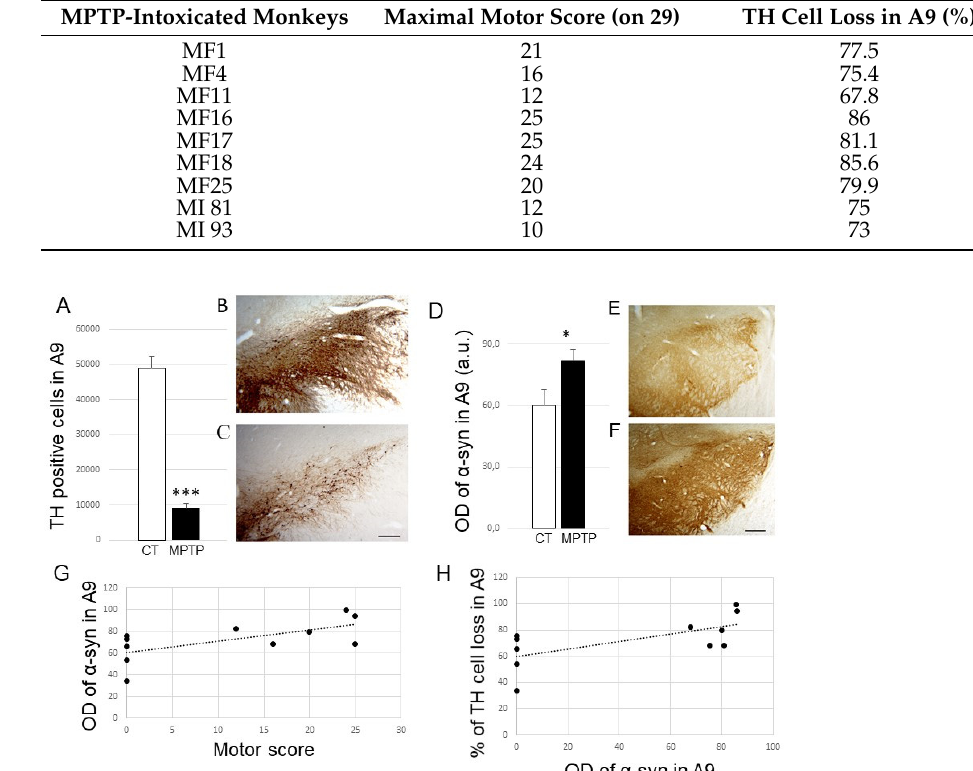
Table 1. Table 1 indicates the maximal parkinsonian score and the percentage of DA cell loss in the substantia nigra pars compacta (A9) obtained for each MPTP-intoxicated monkey. substantia nigra pars compacta (A9) obtained for each MPTP-intoxicated monkey. MPTP-Intoxicated Monkeys Maximal Motor Score (on 29) TH Cell Loss in A9 (%) MF1 MF1